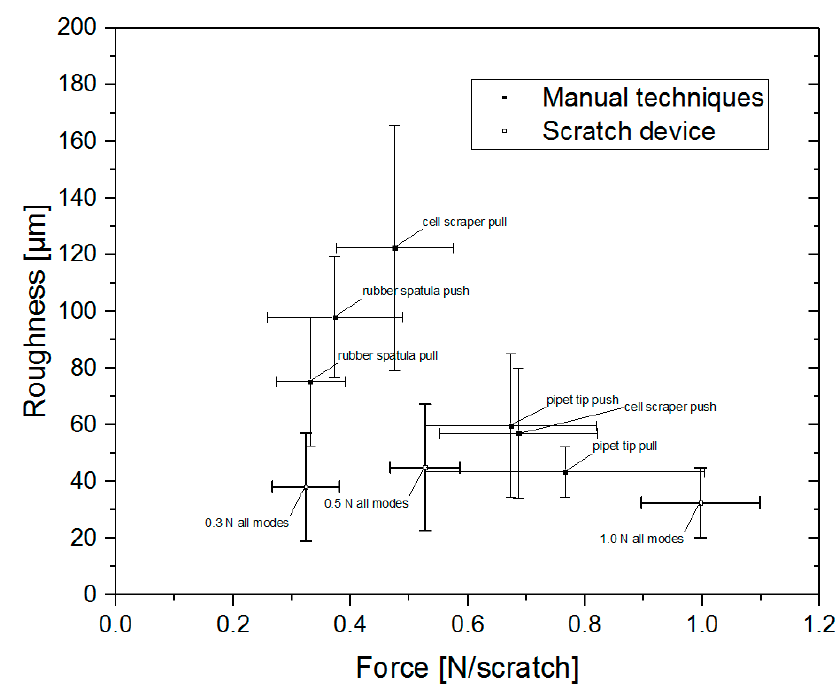
Figure 3. Comparison of manually performed scratch assays versus assays performed with the scratch device (thick lines). Nearly independent from its operation mode, the scratch device achieves scratch borders that show a lower roughness than many conventional methods that allow cell harvesting.